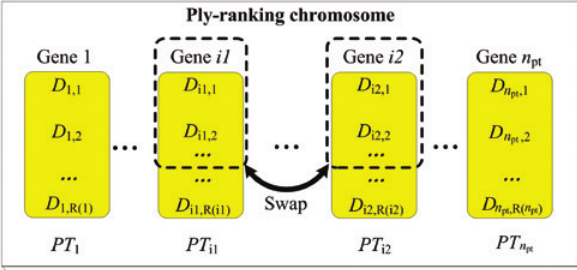
Figure 10: Swapping operations in a ply-ranking